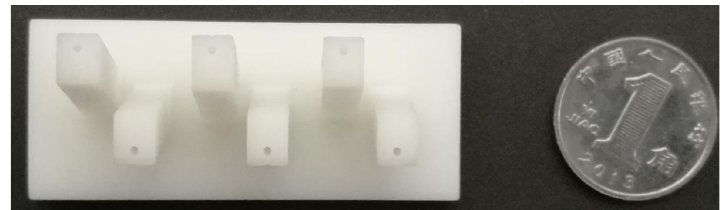
Figure 9. The prototype of the sensor manufactured by means of rapid protoying technology.